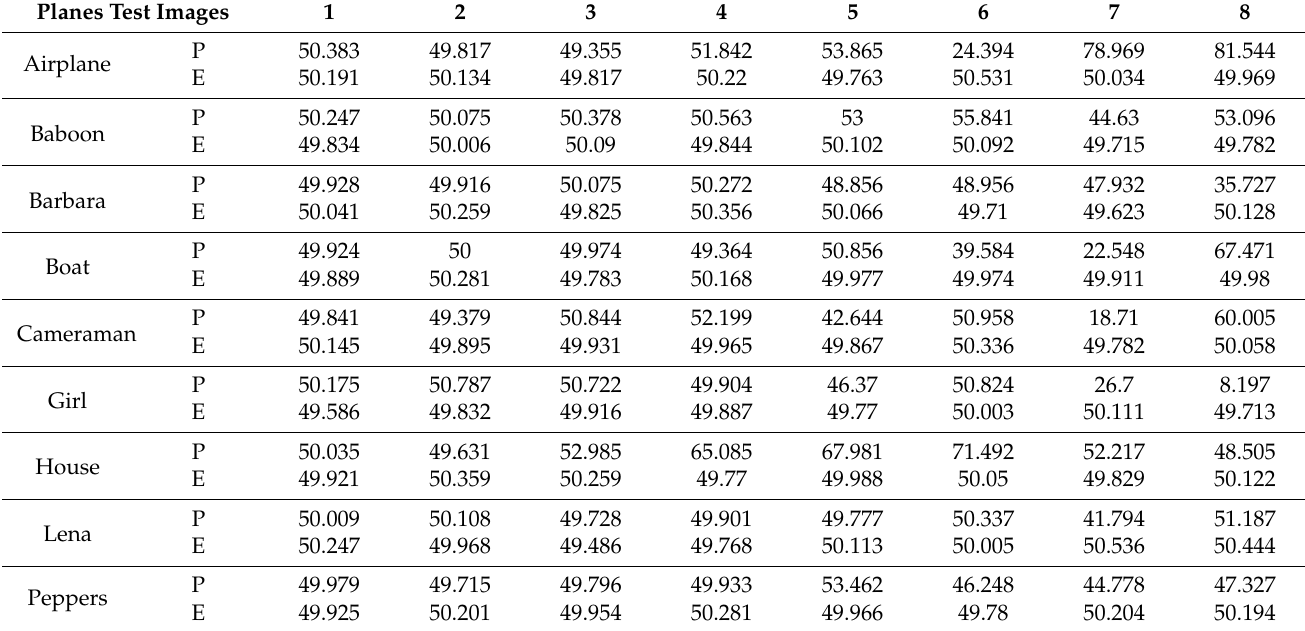
Table 8. Bit distribution analysis at plane level.